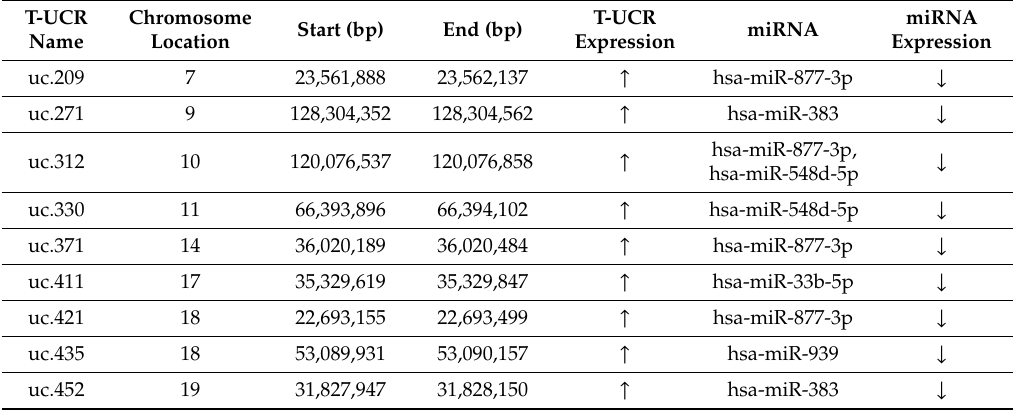
Table1. AlistofT-UCRsnegativelycorrelatedwithmiRNAsinshort-vs.